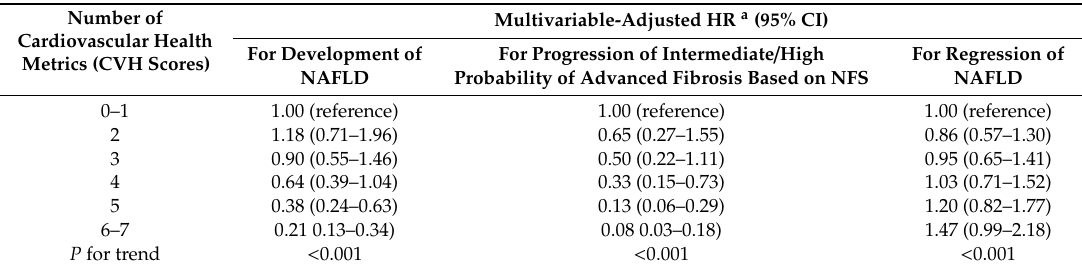
Table A2. Hazard ratios (95% CI) for Development of NAFLD, intermediate / high probability of advanced fibrosis based on NFS and regression of NAFLD by cardiovascular health metrics at baseline among